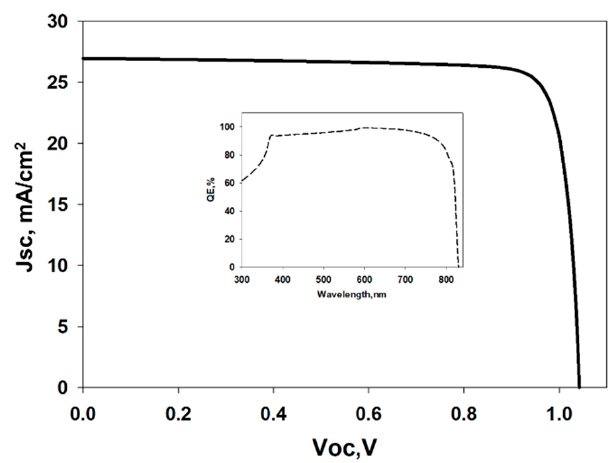
Figure 14. J-V curve of CdTe/WS 2 solar cell; QE% of CdTe/WS 2 solar cell at